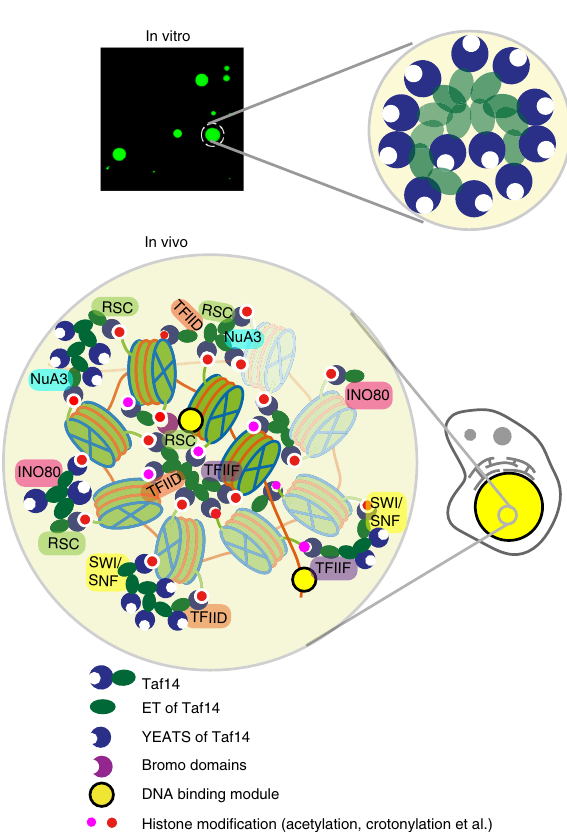
Fig. 7 Proposed model of Taf14 as an organization hub to orchestrate transcription machinery recruitment. Taf14 ET alone and Taf14 ET - complexes undergo LLPS in vitro. Taf14 also contains an N-terminal YEATS domain recognizing acetylated and crotonylated histones. The existence of multiple Taf14 ET -binding motifs, multiple histone and DNA-binding modules in the complexes, as well as various modi fi cations on chromatins can increase binding multivalence between Taf14-containing complexes and chromatins. These Taf14-mediated interactions consequently promote phase separation of condensates in which different transcriptional machinery is concentrated, thereby ensuring ef fi cient